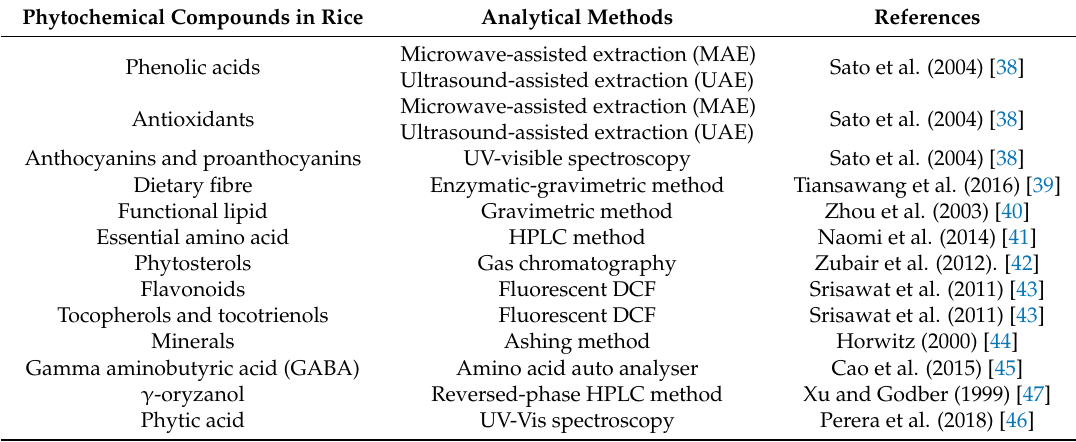
Table 2. Summary of analytical methods used to identify the phytochemical compounds in rice.